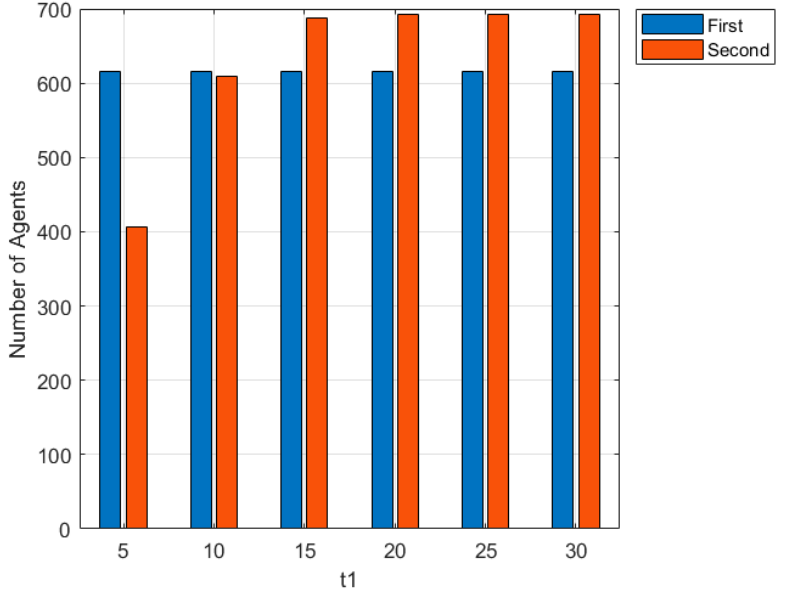
Figure 13. The changes of numbers of interactive nodes under different t 1.